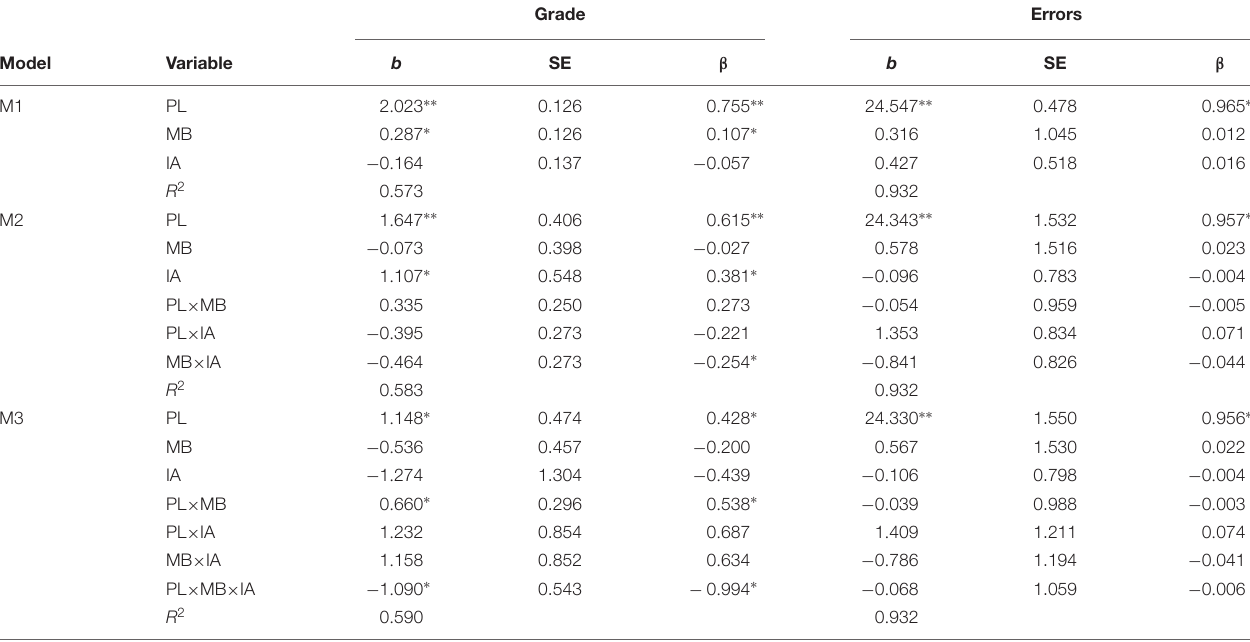
TABLE 3 | Summary of regression analysis for variables predicting errors and